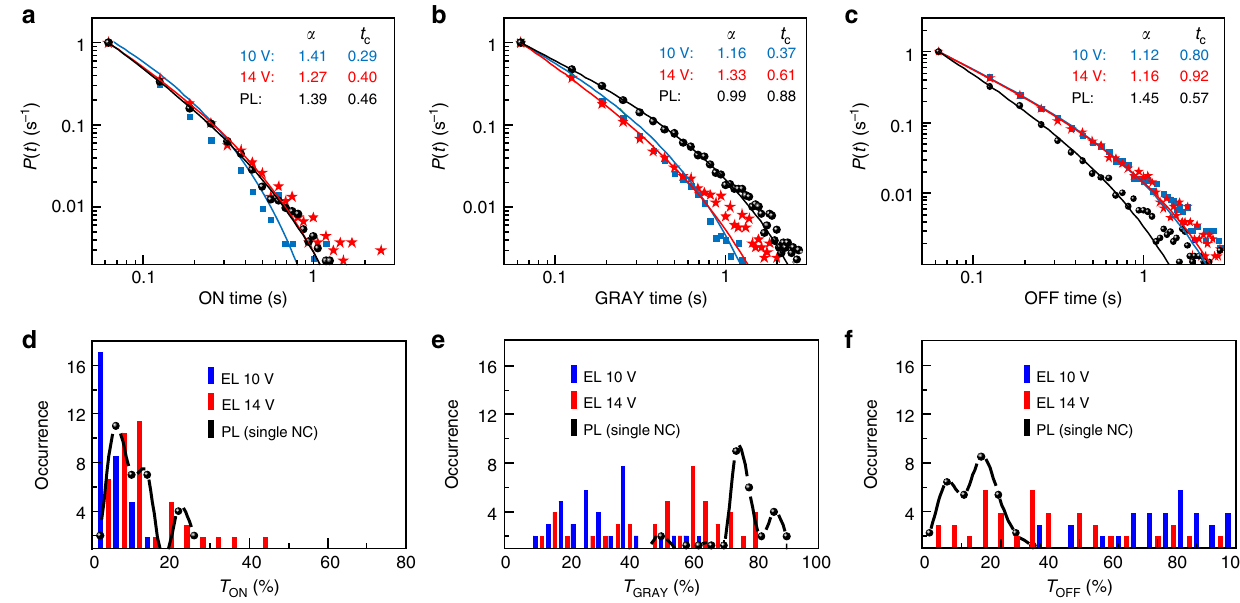
Fig. 3 Blinking analysis of NC aggregates in EL and single NCs in PL. Probability density distributions ( a – c ) and distribution of fractional times ( d – f ) for ON ( a , d ), GRAY ( b , e ), and OFF states ( c , f ) for aggregates of CsPbBr 3 NCs in EL (blue — 10 V bias, red — 14 V bias) and for PL of single CsPbBr 3 NCs in PVK (black). All the probability density curves are fi tted with a truncated power law equation ( P t ð Þ ¼ A t (cid:2) α e (cid:2) t = t c ) and the fi tting coef fi cient values are shown in the individual plots. A fractional time of a state re fl ects a percentage of the whole measurement interval over which the NC was in such